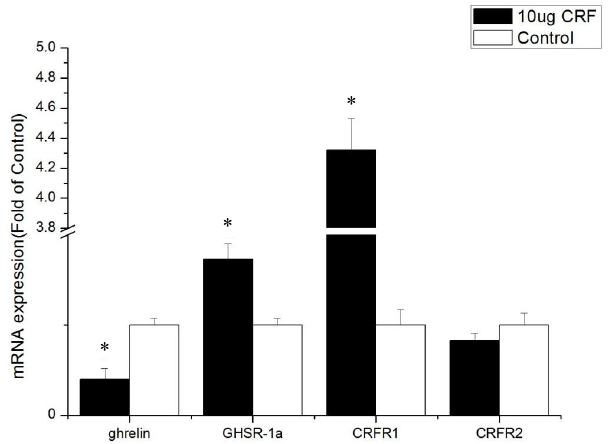
Figure 2. Effect of intracerebroventricular injection of corticotropin-releasing factor (CRF) on genes in hypothalamus of broiler chickens. Control = control group (basal diet); 10 μg = 10 μg/kg body weight. n = 8 * p<0.05 (compared with control).